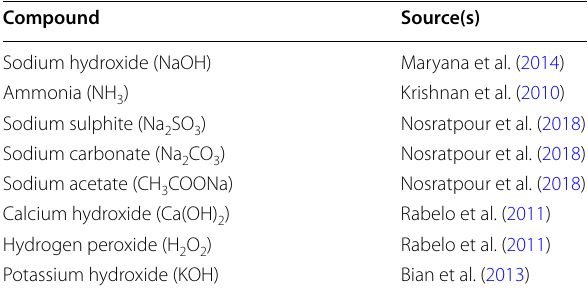
Table 1 Chemical compounds utilised for alkaline pre-treatment